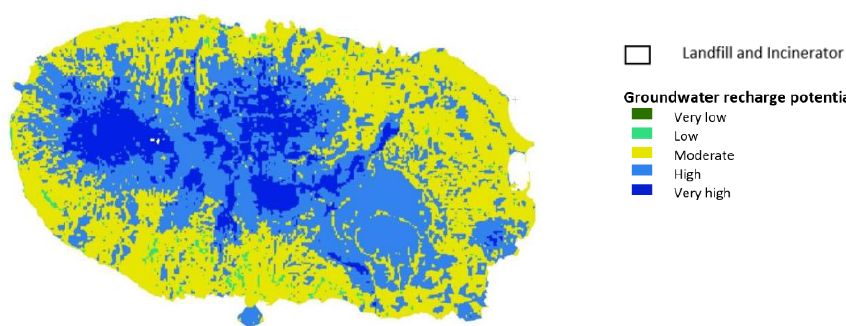
Fig. 12. Potential of groundwater recharge in Terceira Island